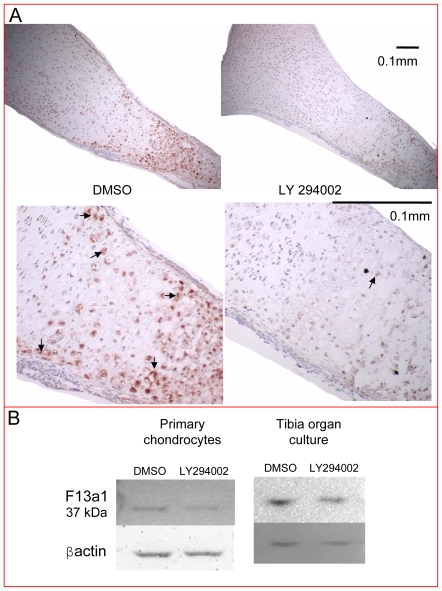
Decreased factor XIIIa protein levels in the tibial growth plate under PI3K inhibition.(A) E15.5 mouse tibiae cultured for 6 days in the presence of DMSO or 10 µM LY294002 were processed for immunohistochemistry. Protein levels of factor XIIIa were decreased in the LY294002-treated growth plates compared to the DMSO control, as shown by the red-brown stain (arrows). (B) Factor XIIIa protein levels were also analyzed by western blotting in both primary cell chondrocyte monolayer cultures after 24 hours and tibiae grown for six days in organ culture, showing decreased factor XIIIa protein levels under PI3K inhibition.